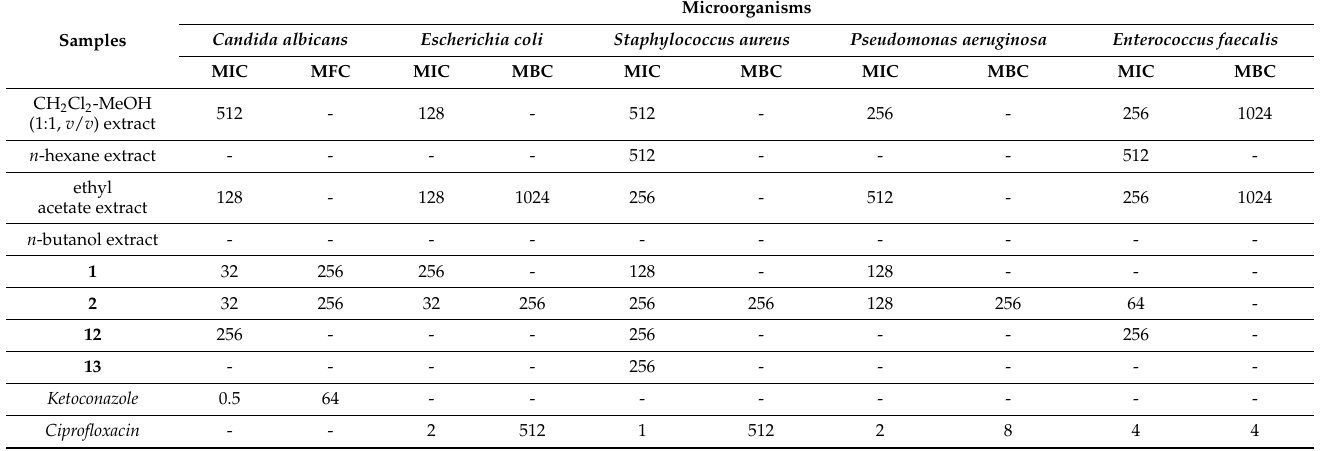
Table 2. Minimum Inhibitory Concentration (MIC), Minimum Bactericidal Concentration (MBC) and Minimal Fungicidal Concentration (MFC) values (in µg/mL) of extracts, fractions, and com- pounds from Albizia lebbeck fruit.